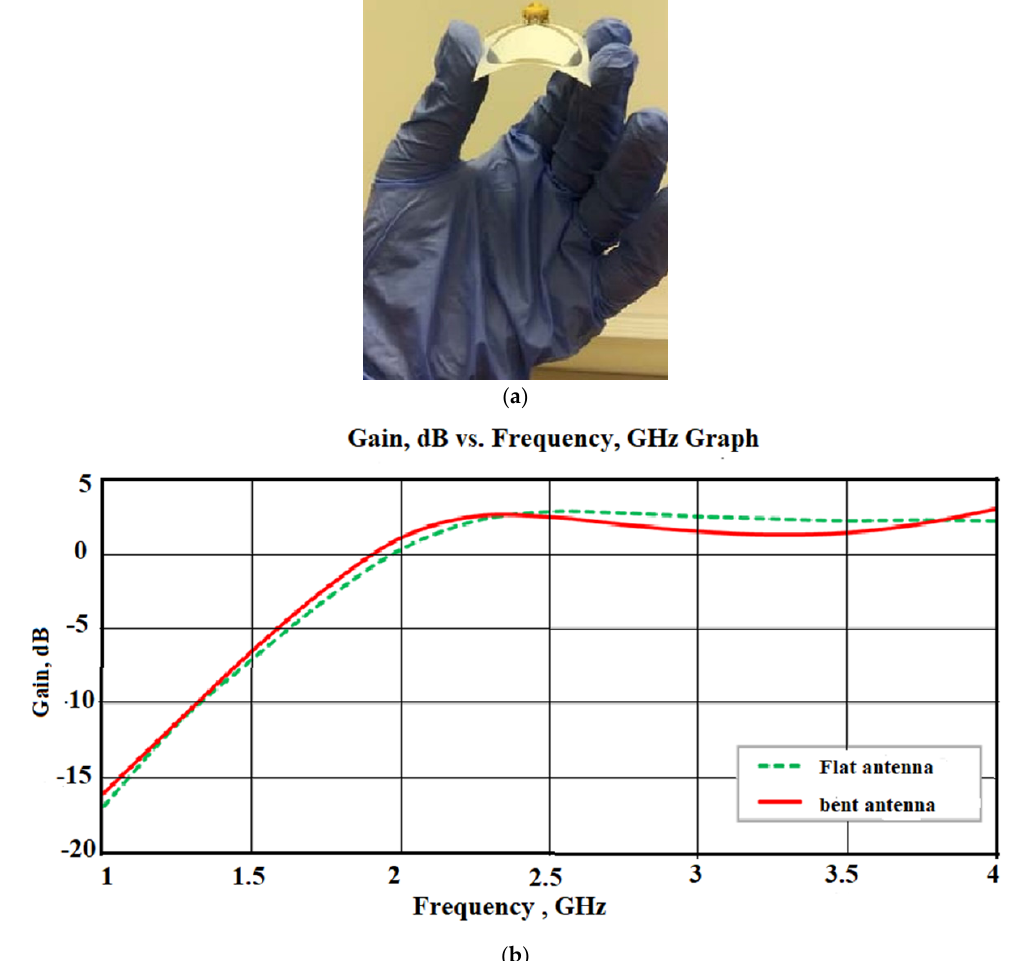
Figure 4. Effect of bending on the gain: ( a ) Bending of a slotted dipole antenna; ( b ) Gain analysis of the antenna under flat and bent conditions. Reprinted from ref. [42] .